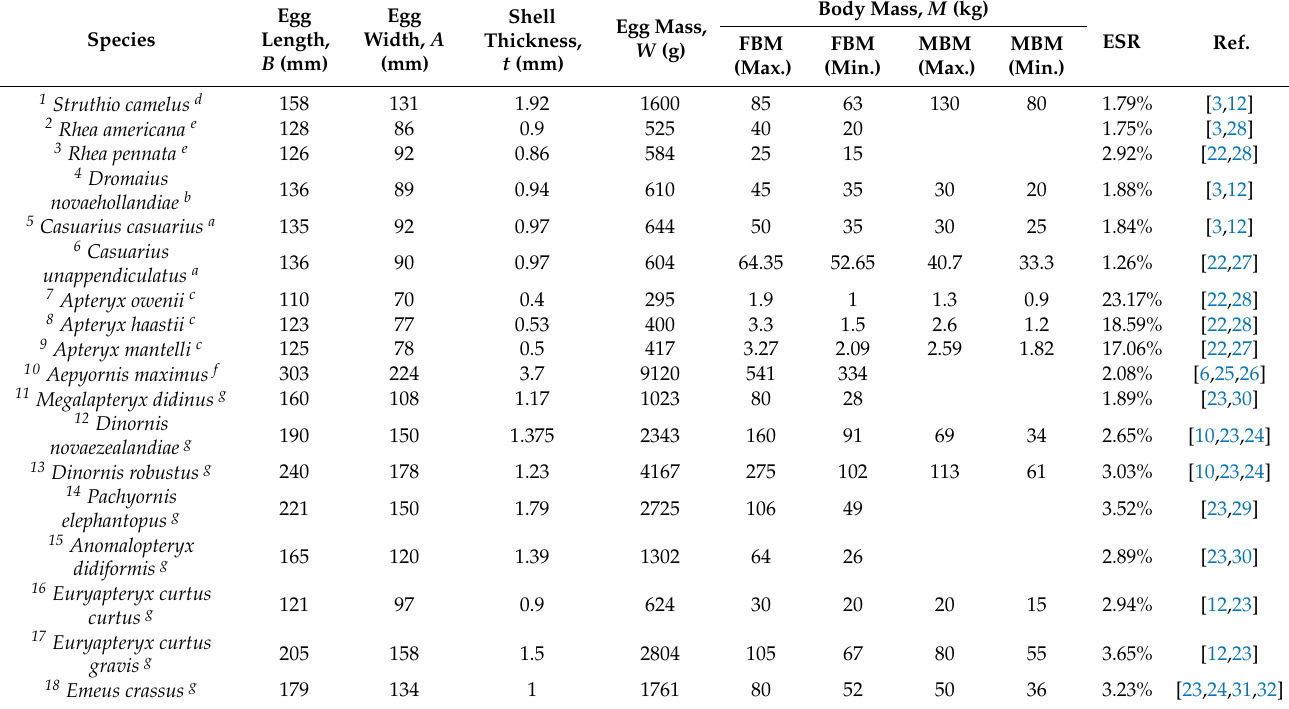
Table 1. Absent of MBM indicates that species with no SSD or RSSD. FBM: female body mass (kg), MBM: male body mass (kg), and ESR: egg size ratio (egg mass divided by average body mass). a cassowary, b emu, c kiwi bird, d ostrich, e rhea, f elephant bird, g moa.